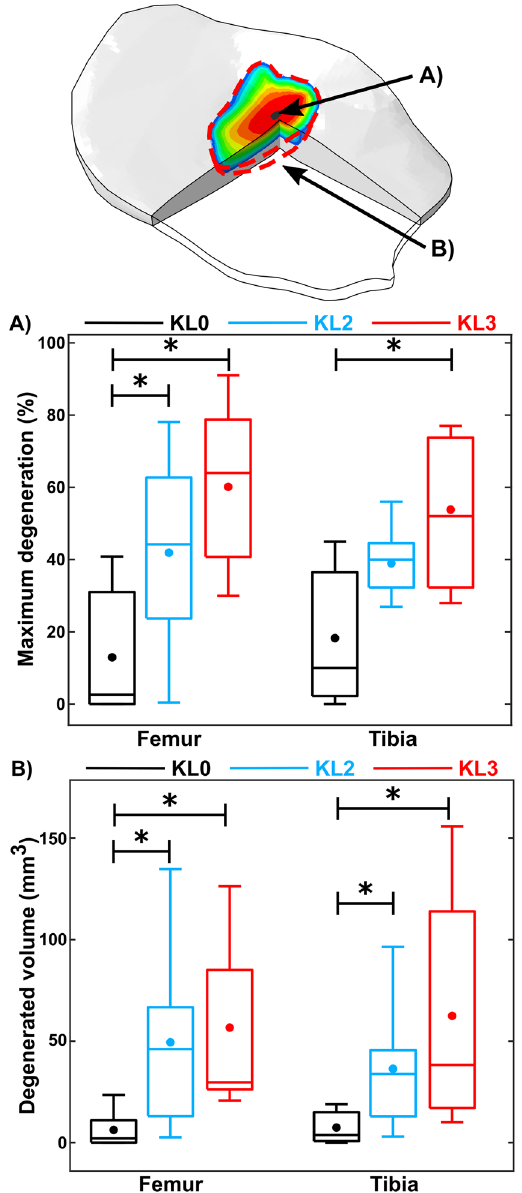
Figure 5. Predicted ( A ) maximum degenerations and ( B ) degenerated volumes of different KL groups in medial femoral and tibial cartilages. Circle ( • ) and crossline (—) represent mean and median values, respectively. * p <